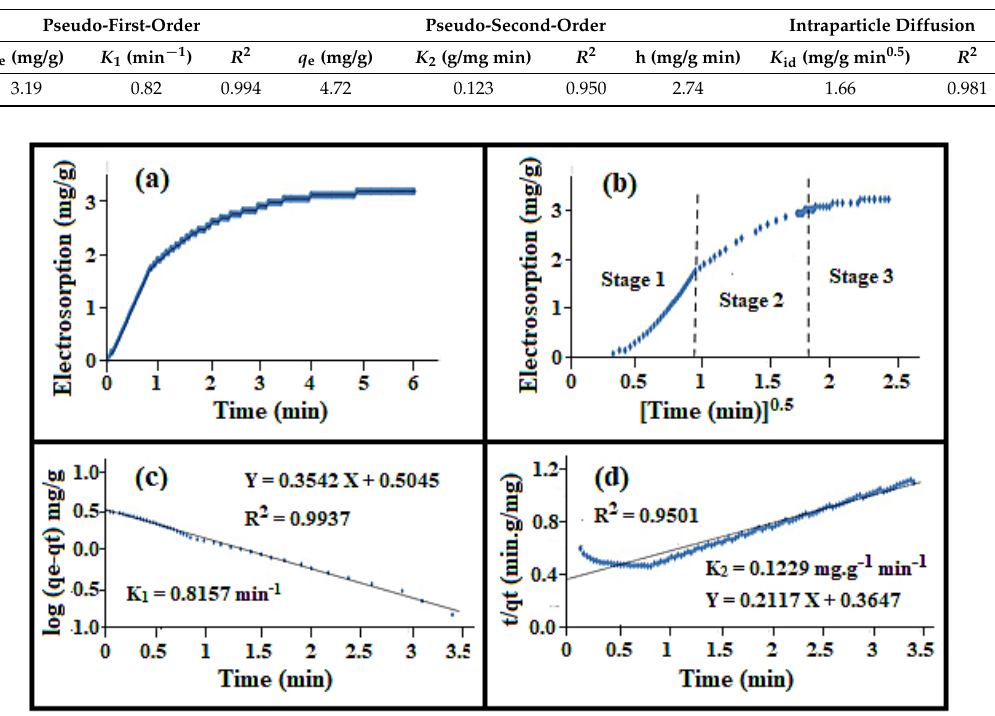
Table 5. Different parameter values obtained using the pseudo-first-order model, pseudo-second-order model, and intraparticle diffusion.